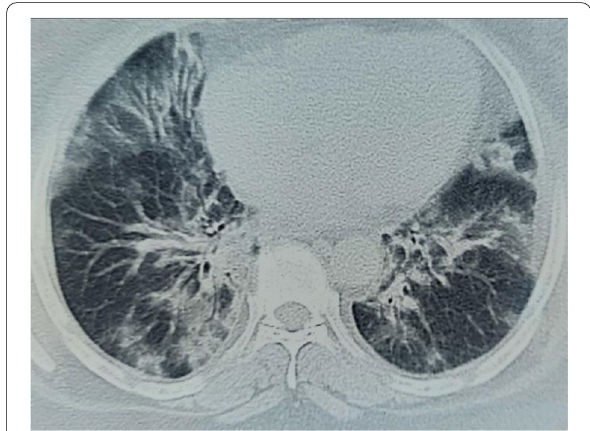
Fig. 2 HRCT done on presentation to the ER that shows B/L ground glass infiltrates with patchy consolidations involving mainly the peripheries